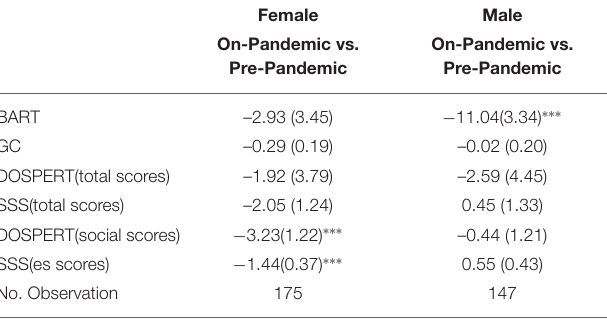
Female Male On-Pandemic vs. On-Pandemic vs. Pre-Pandemic